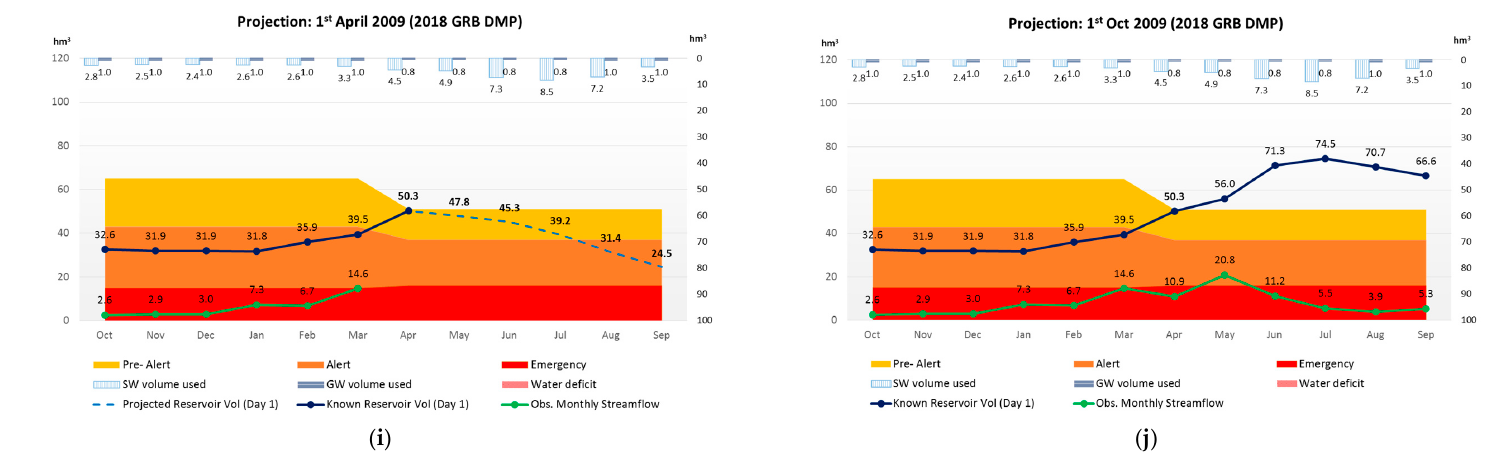
Figure 6. 2018 GRB DMP: Measures taken in April ( a,c,e,g,i ) and evaluation of the real situation made in October ( b,d,f,h,j ).